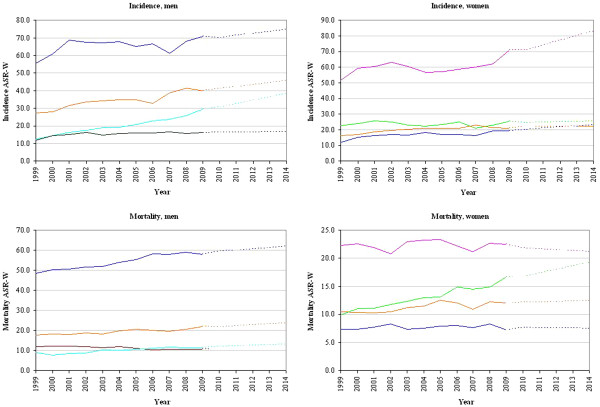
Trends in incidence and mortality from the four most common cancers in Serbia (1999–2009) and predictions (2010–2014). Legend: Blue line – lung cancer. Orange line – colorectal cancer. Turquoise line – prostate cancer. Green line – bladder cancer. Dark red line – stomach cancer. Pink line – breast cancer. Light green line – cervical cancer.